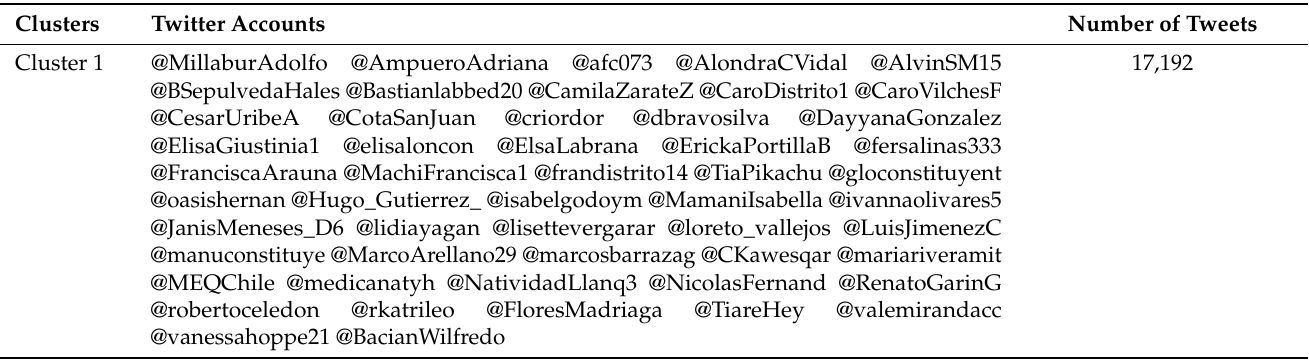
Table 1. Clusters and Twitter